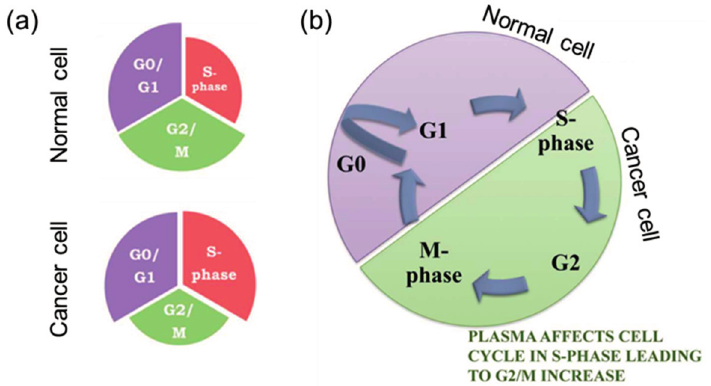
Figure 12. Schematic model of APP effects on the cell cycle. ( a ) Schematic representation showing a higher percentage of cancer cells than normal cells in the S-phase of the cell cycle; ( b ) Schematic representation of APP targeting the S-phase, leading to an increase of cells in the G2/M phase. Adapted from [74] with permission from Macmillan Publishers, Ltd.,